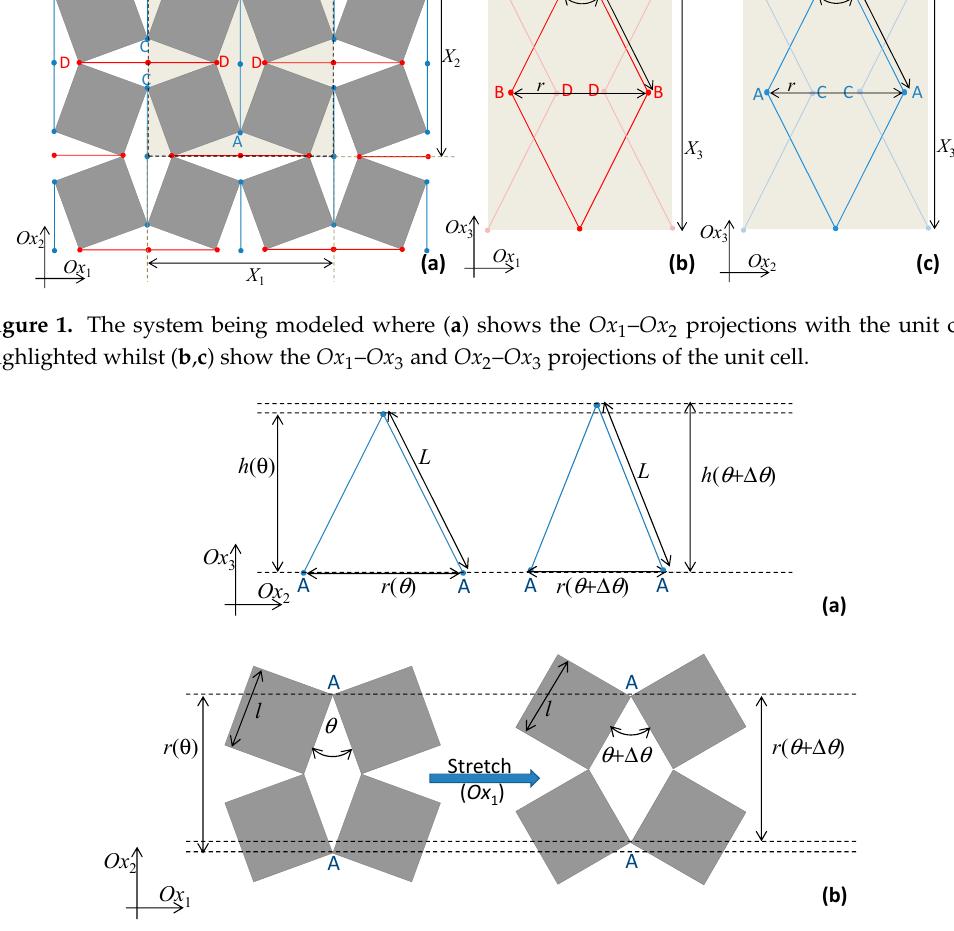
Figure 2. The auxetic-generating ‘triangular elongation mechanism’ being proposed; illustrated in ( a ) through a triangular building block where the base corresponds to the distance between two opposite vertices in the pore of the ‘rotating squares’ structure shown in ( b ). Note that as the system is stretched in the Ox 1 direction, the square units located in the Ox 1 – Ox 2 plane rotate relative to each other from an angle θ to θ + d θ with the consequence that the distance between opposite vertices A and A (= r ) decreases. This forces the triangular units located in the orthogonal plane to elongate, causing an increase in h and generating a negative Poisson’s ratio.